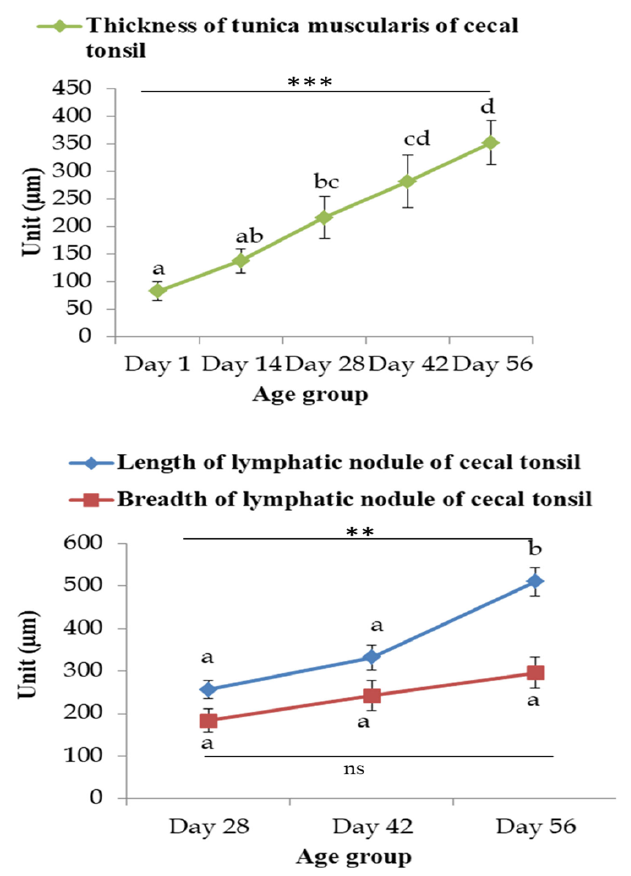
Figure 3. Analysis of thickness of tunica muscularis and length and breadth of lymphatic nodules (mean±standard error mean). a-d Values with different letters within the same line differ significantly ( P ≤ 0.05)